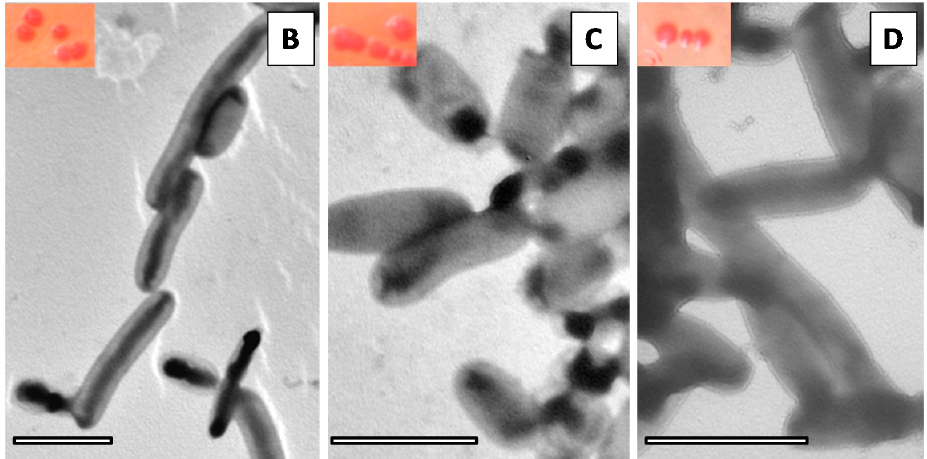
Figure 4. The extracellular polymeric matrix of K. pneumoniae biofilm. ( A ) The results of enzymatic digestion of Kp biofilms are presented (* p < 0.05). In the insets of figures ( B – D ) are shown CFU of: ( B ) Kp703; ( C ) Kp45; and ( D ) Kp2948 grown on MH-Congo red after recovery from biofilms assembled